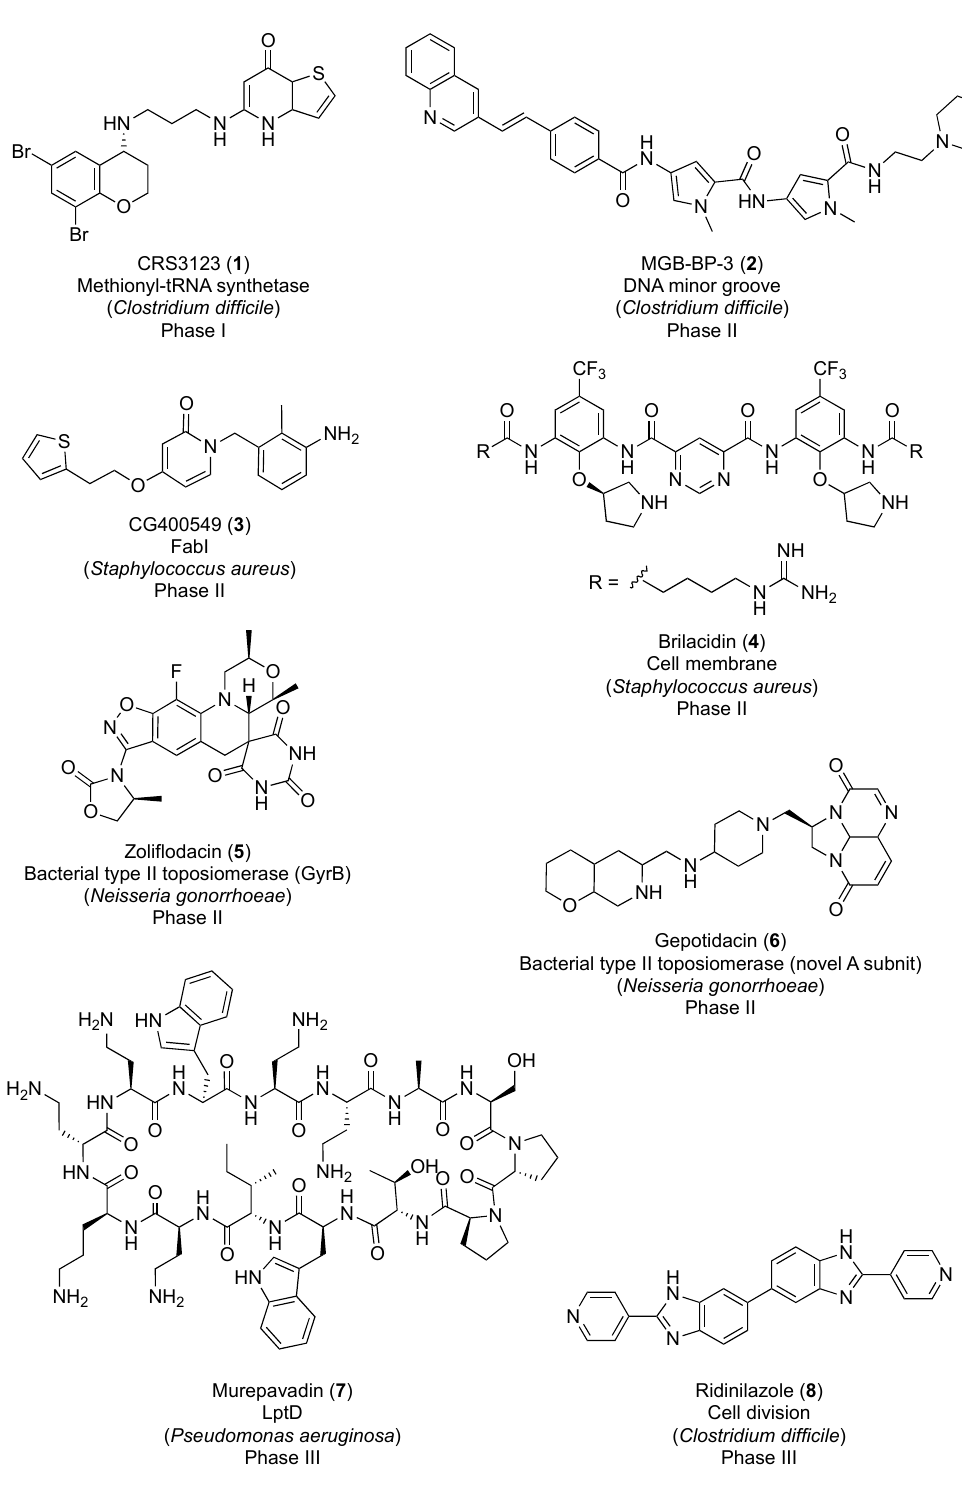
Figure 1. New-generation antibiotics in clinical trials.